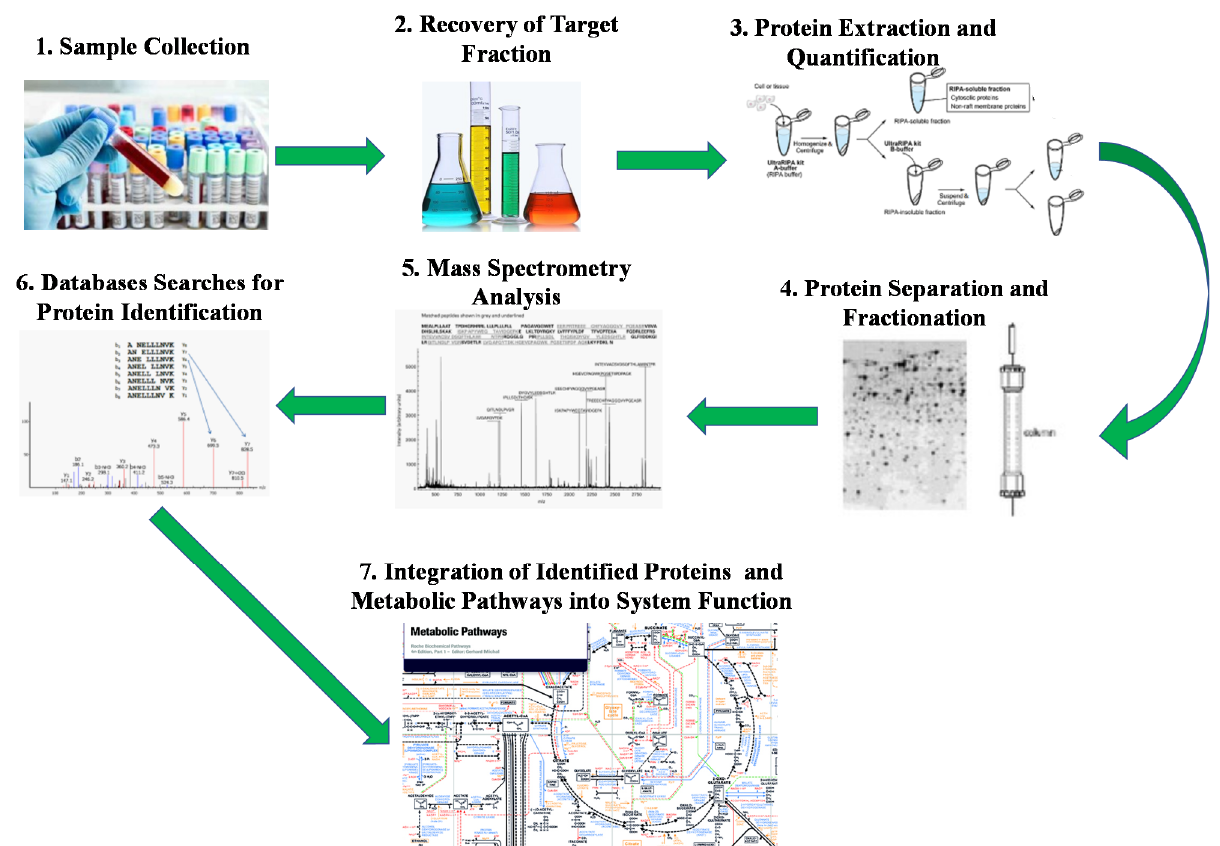
Figure 3. Typical workflow for (meta) proteomics analysis [based on [91]]. Initially, the samples are collected from the biological community then the microbial fraction or extra cellular components are separated from the sample. After protein extraction, gel-based or gel-free methods can be used to separate proteins that are then analyzed through mass spectrometry (e.g., peptide sequence or peptide mass fingerprint). After determining the peptide amino acids, tandem mass spectra of peptides can match database-derived protein sequences and finally the proteins can be linked to different metabolic